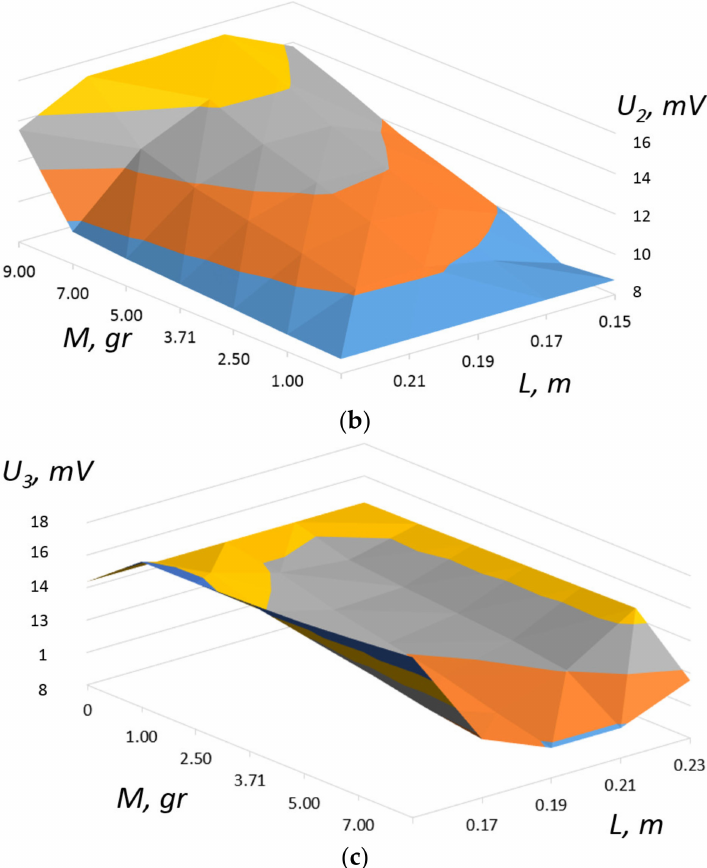
Figure 7. Dependence of the output voltage U on the electrodes of the corresponding PE at an active load of 1000 Ω for 1 vibration mode. Respectively, for ( a ) piezocylinders (U 1 ) and ( b , c ) piezoelectric elements in the form of plates (U 2 and U 3 ).